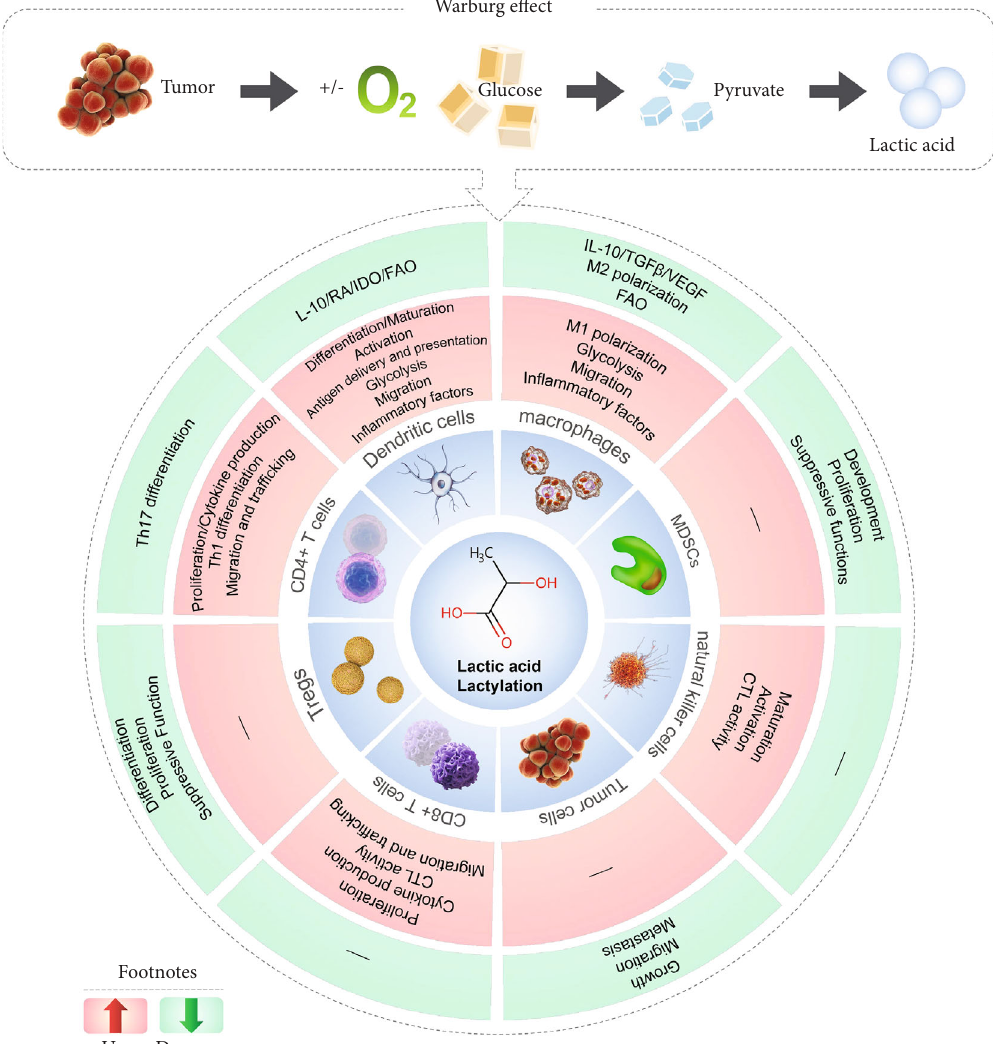
Figure 1: Lactic acid/lactylation regulates tumor-associated immune cell